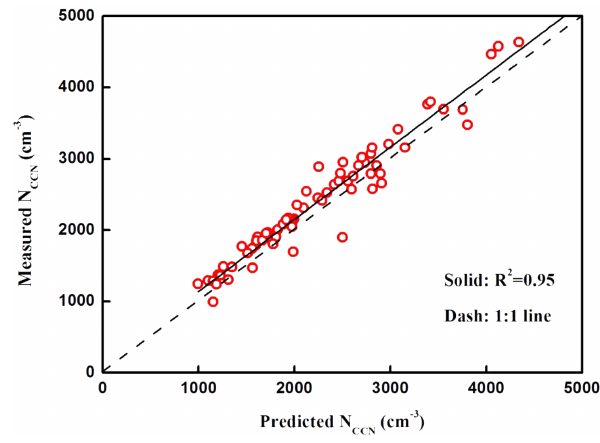
Figure 10. Scatterplot of the simplified closure analysis at SS 0.2%.